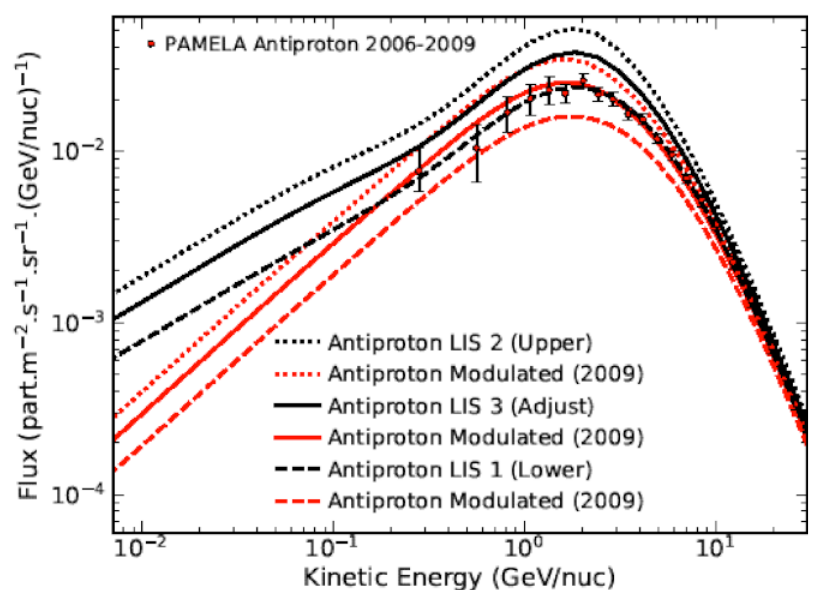
Figure 15. Computed LISs for anti-protons as a function of kinetic energy using two GALPROP models as described in the text, here indicated at 122 AU as LIS 1 Lower (dashed line) and LIS 2 Upper (dotted line). Corresponding modulated spectra at the Earth (red lines), based on modulation conditions for 2009, are found either too high or too low so that an averaged LIS is calculated as LIS 3 Adjust (black solid line) with the corresponding modulated spectrum (solid red line) reproducing optimally PAMELA observations averaged for 2006 to 2009 [152] (filled circles with error bars).